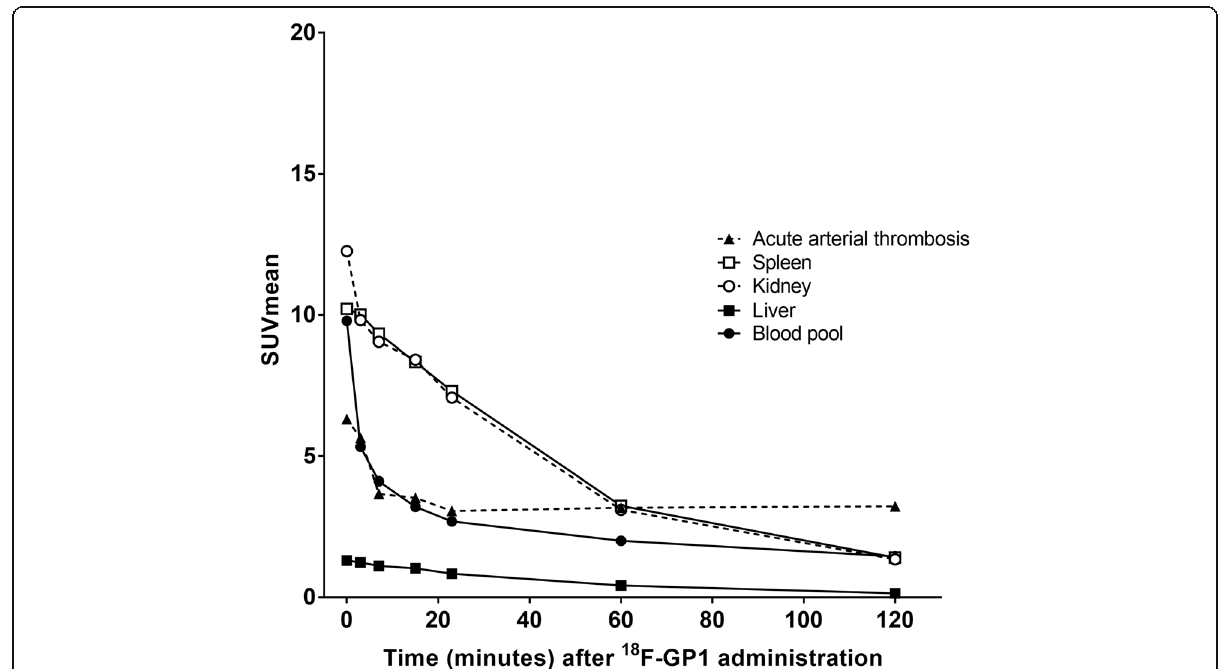
Fig. 1 18 F-GP1 biodistribution over time. The 18 F-GP1 uptake in the kidney, spleen and blood gradually decreases over time. The 18 F-GP1 uptake in AAT lesions remains constant from 7 min after injection. The median values of ten patients are shown